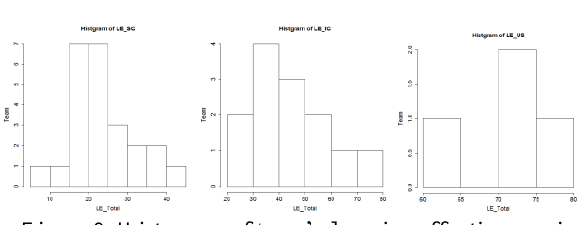
Figure 9. Histogram of team’s learning effectiveness in each course (left: SDC, center: ITC, right: ODC)